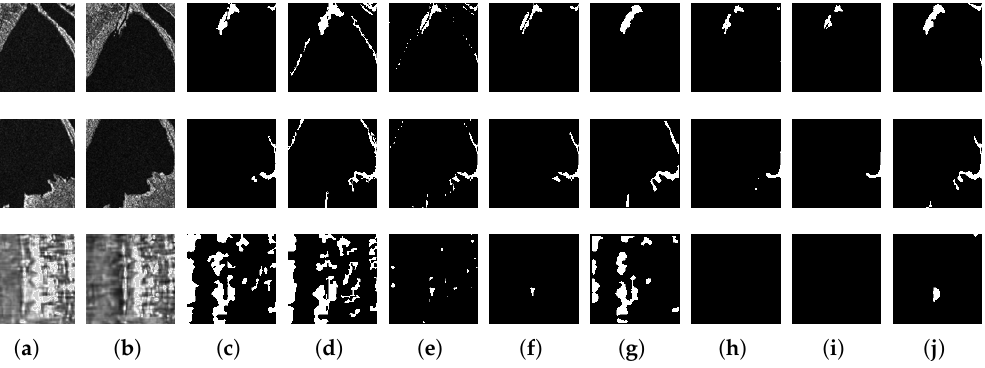
Figure 19. The three lines represent the 23rd, 39th and 53rd patches with poor detection